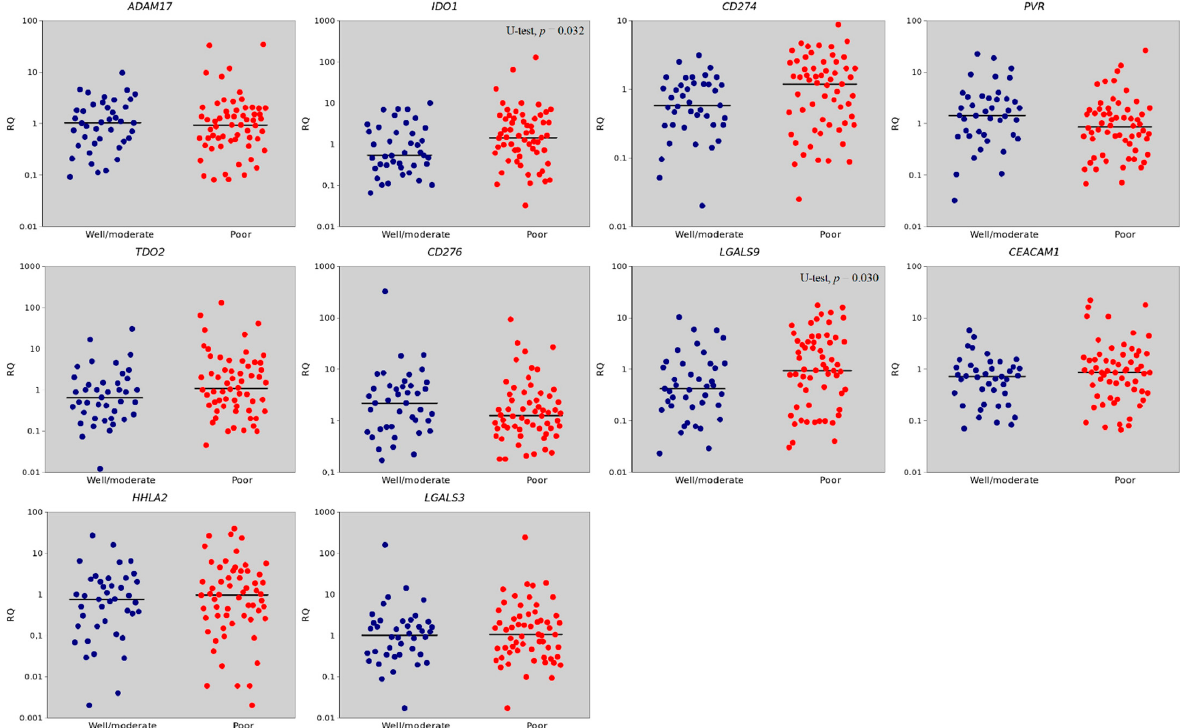
Figure 6. The relative gene expression (RQ) in poorly differentiated tumors (red dots) and well/moderately differentiated tumors (blue dots). Gene expression values are presented on a logarithmic scale. The line marks the